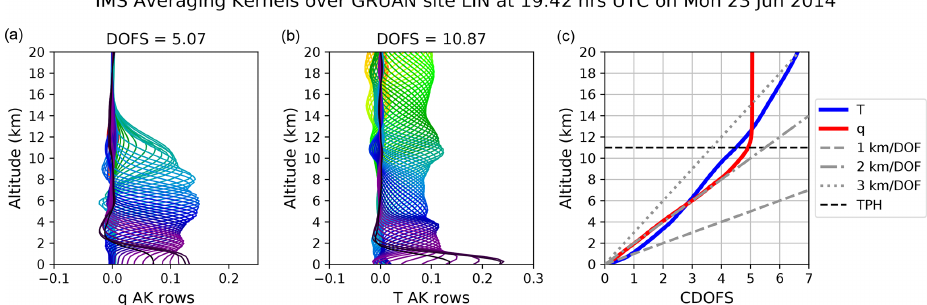
Figure 4. Example of averaging kernels (AKs) for IMS water vapour ( q ) and temperature ( T ) profiles extracted over the GRUAN Lindenberg (LIN) site. Panel (c) shows the cumulative degrees of freedom for signal (CDOFS) values, which illustrates how the vertical distribution information content can be related to profile vertical resolution. In the lower–middle troposphere, the water vapour CDOFS aligns with a vertical resolution of 2km. Above 8km, the gradient swiftly becomes zero around the tropopause height (TPH). The temperature profile starts at a 1km vertical resolution and reduces to 2km at 6km. Above this height, the gradient shows the vertical resolution changes to ≈ 2.5km, which remains consistent into the upper troposphere and lower stratosphere (UTLS) before further degrading to 3km per degree of freedom (DOF).